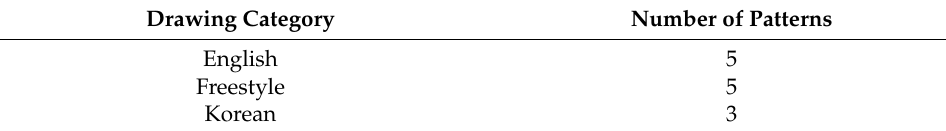
Table 2. Details of drawing patterns used in this study.